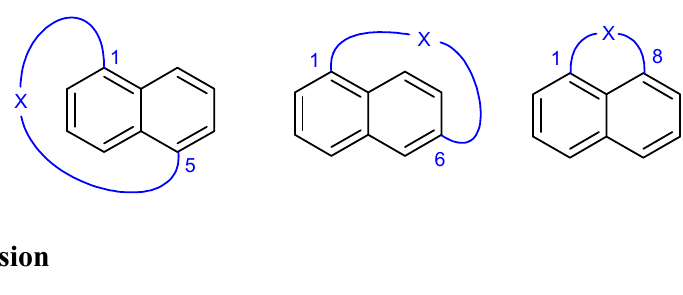
Figure 1. 1,5-, 1,6- and 1,8-Naphthalenophanes.